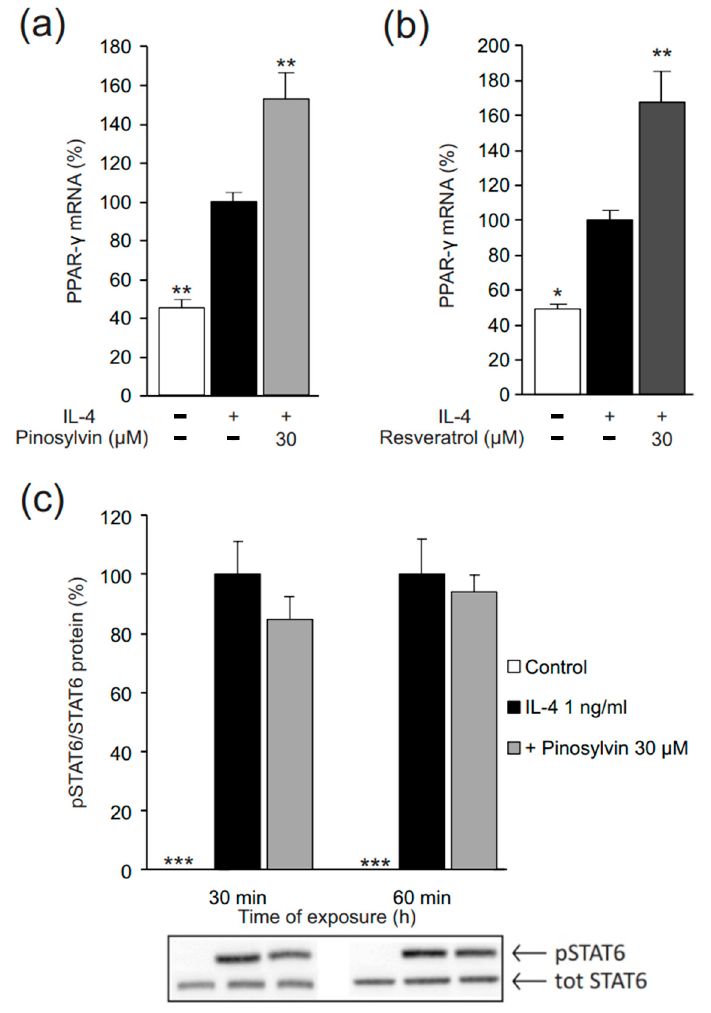
Figure 5. Pinosylvin ( a ) as well as resveratrol ( b ) enhanced IL-4-stimulated peroxisome proliferator- activated receptor γ (PPAR- γ ) expression but had no effect on the phosphorylation (i.e., activation) of signal transducer and activator of transcription 6 (STAT6) ( c ) in J774 murine macrophages. J774 cells were cultured with IL-4 (1 ng/mL) alone, or together with pinosylvin or resveratrol for 4 h ( a , b ), or for 30 or 60 min as indicated ( c ). Expression of PPAR- γ mRNA was measured by quantitative reverse transcriptase polymerase chain reaction (qRT-PCR) and normalized against GAPDH mRNA. STAT6 phosphorylation was measured with Western blot, and phosphorylated STAT6 was normalized against the total STAT6 protein. The results are expressed as mean + SEM, n = 4. Statistical significance of the results was calculated by one-way ANOVA followed by Bonferroni multiple comparisons test. * = p < 0.05, ** = p < 0.01, and *** = p < 0.001 as compared to cells cultured with IL-4 only, marked as a black bar.